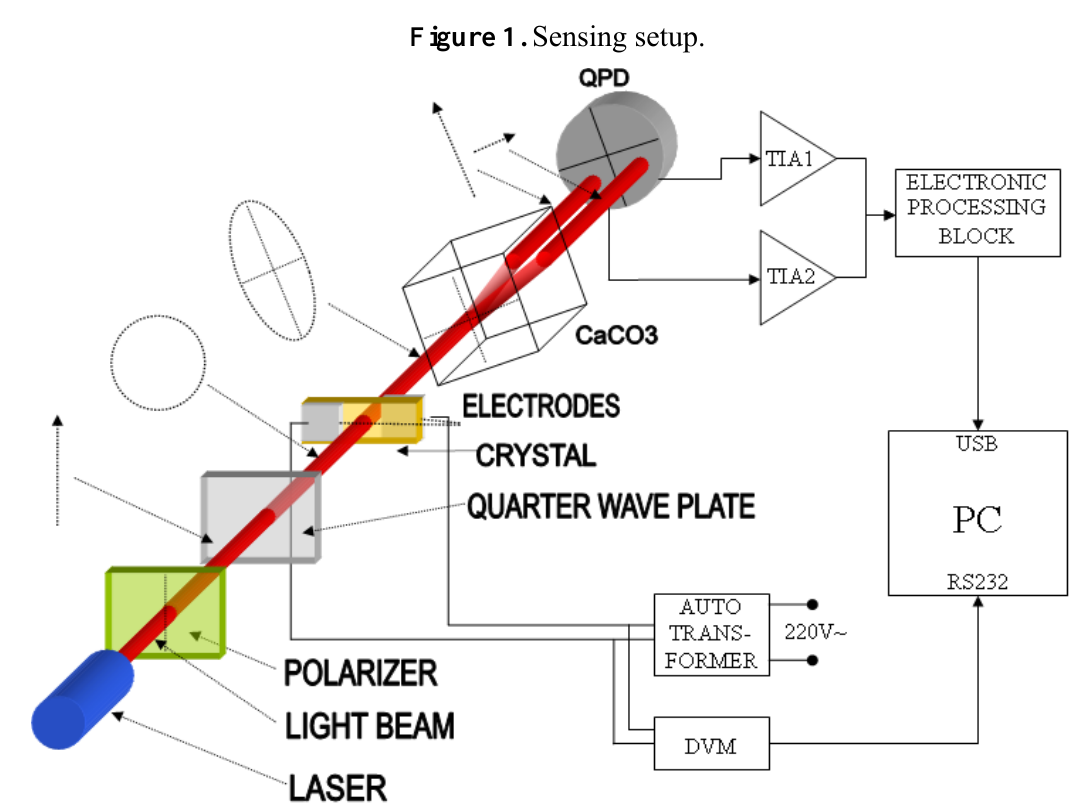
Figure 1. Sensing